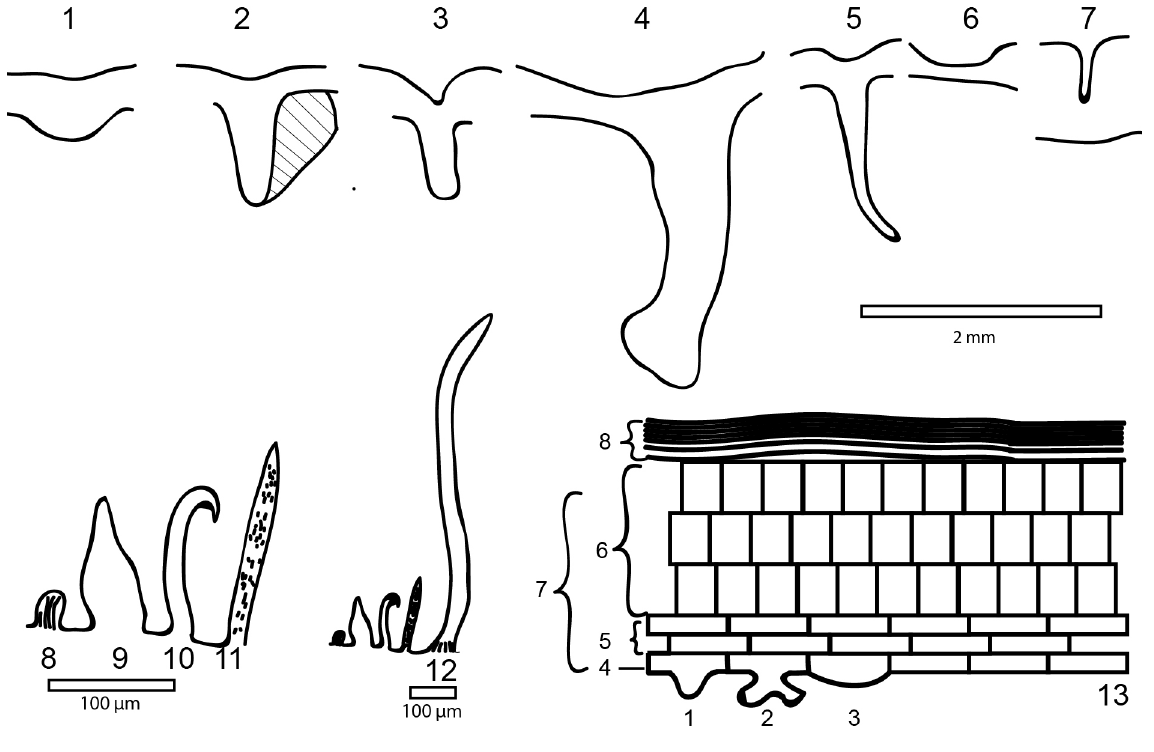
Fig. 2. Shapes of tubercles and hairs and the endocarp wall anatomy of Icacinaceae Miers. 1 – 7 . Tubercle shapes in transverse section. 1 . Bullate. 2 . Elongate-flattened. 3 . Peg-shaped. 4 . Cylindrical. 5 . Spiny. 6 . broad, concave pit. 7 . Narrow pit. – 8 – 12 . Hairs shapes. 8 . Papillae like. 9 . Small ovoid hairs with an acuminate apex. 10 . Uncinate hairs. 11 . Simple hairs with granular ornamentation. 12 . Long and thin hairs. 13 . Endocarp wall anatomy: 1 = rounded papillae; 2 = elongate papillae; 3 = inflated cell; 4 = periclinally oriented cells lining the locule; 5 = layer of periclinally oriented cells; 6 = layer of anticlinally oriented cells; 7 = endocarp wall; 8 = mesocarp wall when dry. Image modified from Del Rio